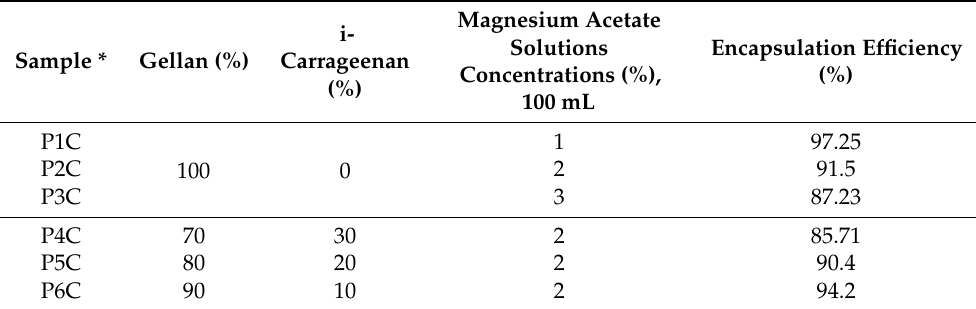
Table 2. The polymer matrix composition and the encapsulation